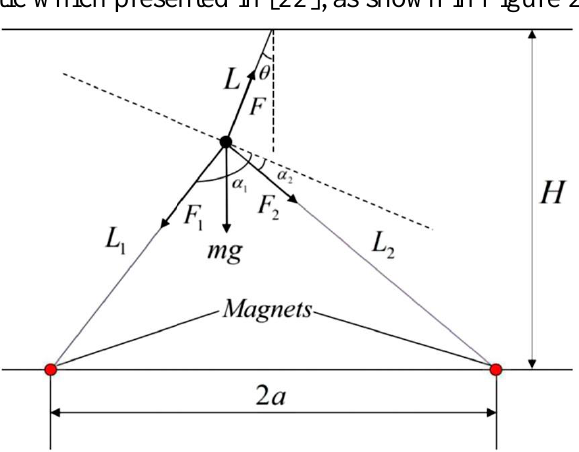
Figure 2 . Pendulum system under action of double magnets